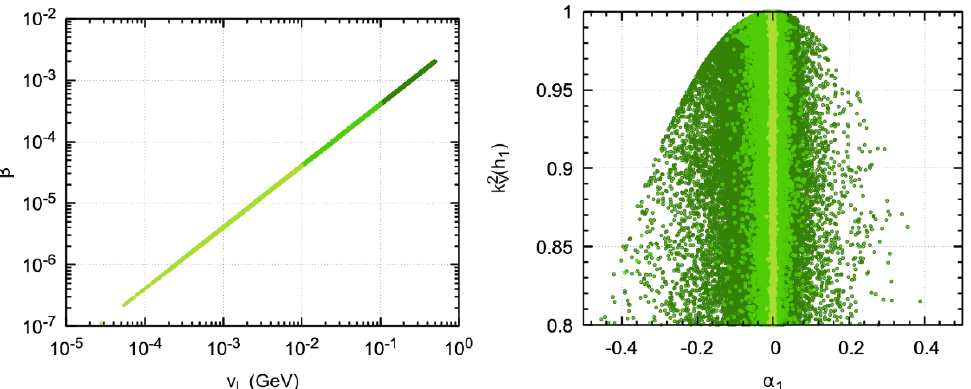
Figure 4 . Left panel: correlation between (cid:12) and v L . Right panel: correlation between k 2 (cid:11) 1 . The color code is as in (cid:12)gure 2. See text for the explanation.